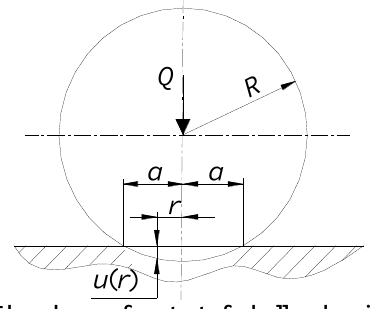
Fig.1. The scheme of contact of a ball and a viscoplastic